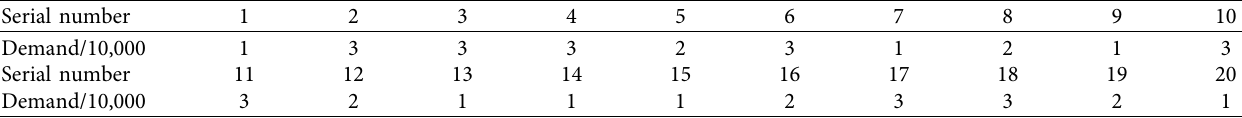
Table 11: Initial green product demands of retailers/consumers.